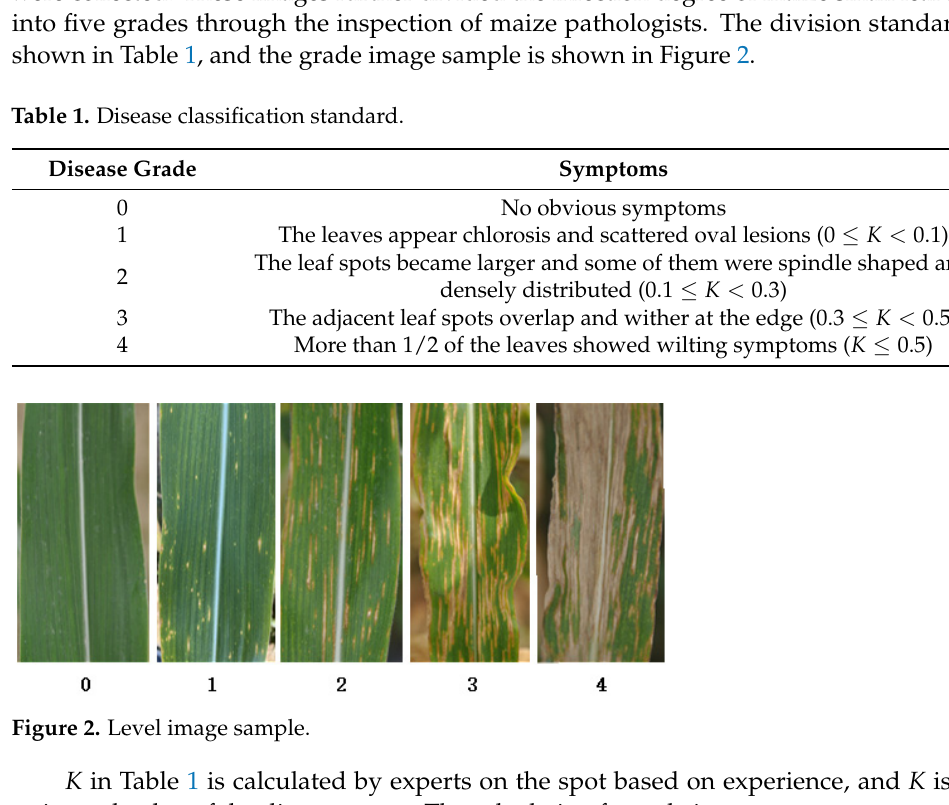
Figure 1. Maize experimental field.